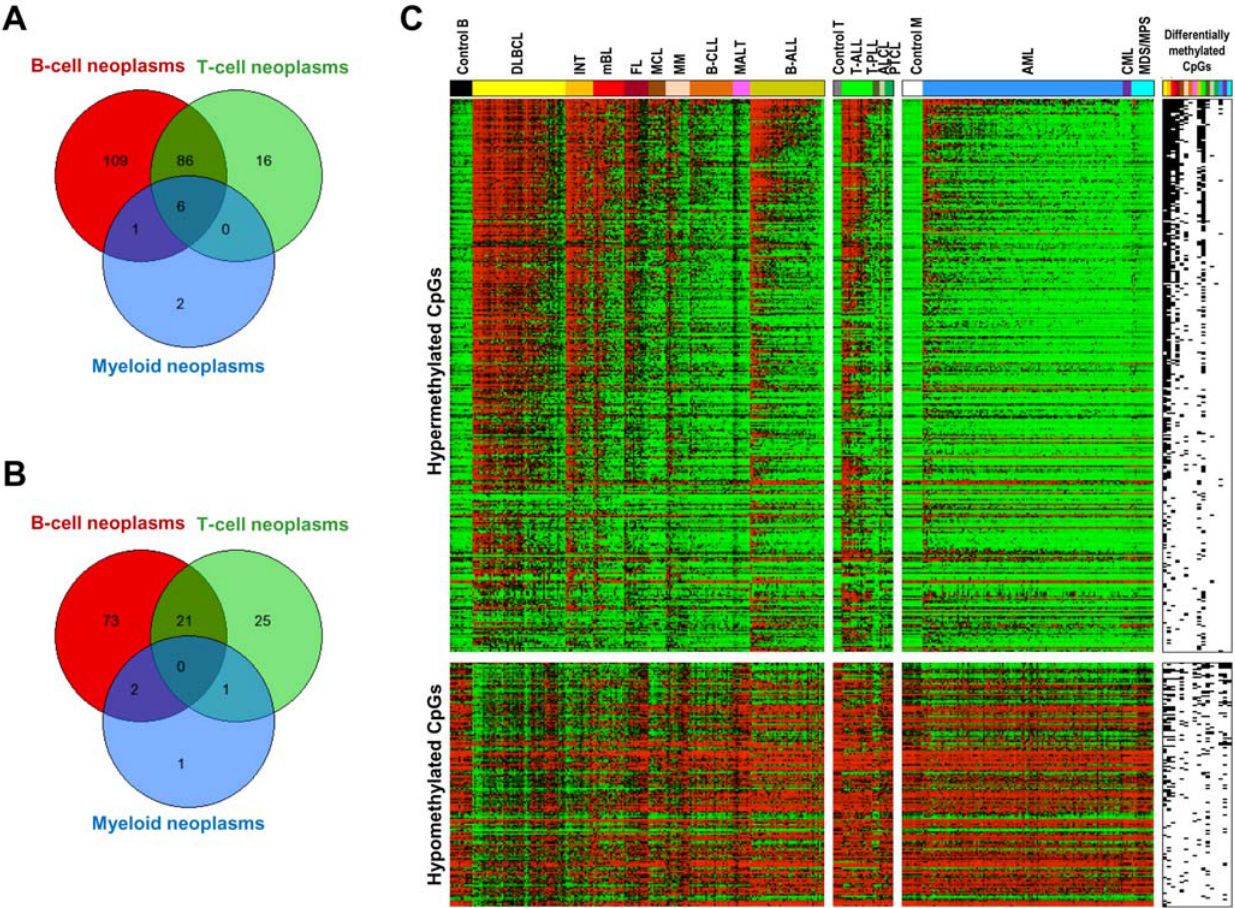
Figure 4. Venn diagrams showing the overlap of genes. (A) Hypermethylated or (B) hypomethylated in B-cell, T-cell and myeloid neoplasms. Only six genes were significantly hypermethylated in neoplasms of B-cell, T-cell and myeloid origin. We did not detect any gene hypomethylated in tumors of all three cellular origins. (C) Heatmap containing all the CpGs hypermethylated (above) or hypomethylated (below) in at least one HN subtype. CpGs are arranged in decreasing order of hypermethylation frequency. The presence of hypermethylated or hypomethylated CpGs in a given HN subtype is shown on the right of the heatmap (black: differentially methylated).